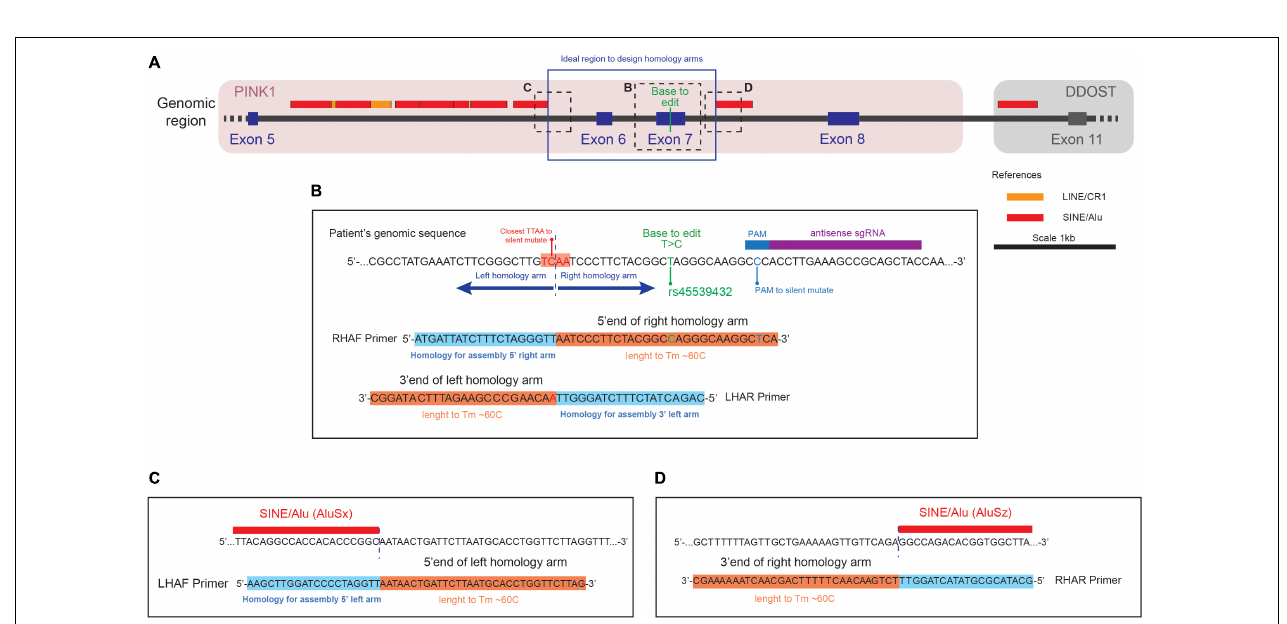
FIGURE 2 | Representation of the genomic region to correct the transition (c.1366T > C, NM_032409.2) in the PINK1 gene (A) Genomic region around the PINK1 Q456X mutation identifying the position of the base to edit respect of the repetitive elements in the area. (B) Close up of the genomic sequence centered in the Base to Edit (BTE), with the design of the primer Right Homology Arm Forward (RHAF) and Left Homology Arm Reverse (LHAR). Notice that the RHAF primer carries the correction of the BTE and a silent mutation to avoid PAM recognition. Also notice that the LHAR primer carries the silent mutation to generate a TTAA site close to the BTE. (C) Close up of the genomic region that is the boundary of the left homology arm, with the design of the Left Homology Arm Forward (LHAF) primer. (D) Close up of the genomic region that is the boundary of the right homology arm, with the design of the Right Homology Arm Reverse (RHAR) primer.